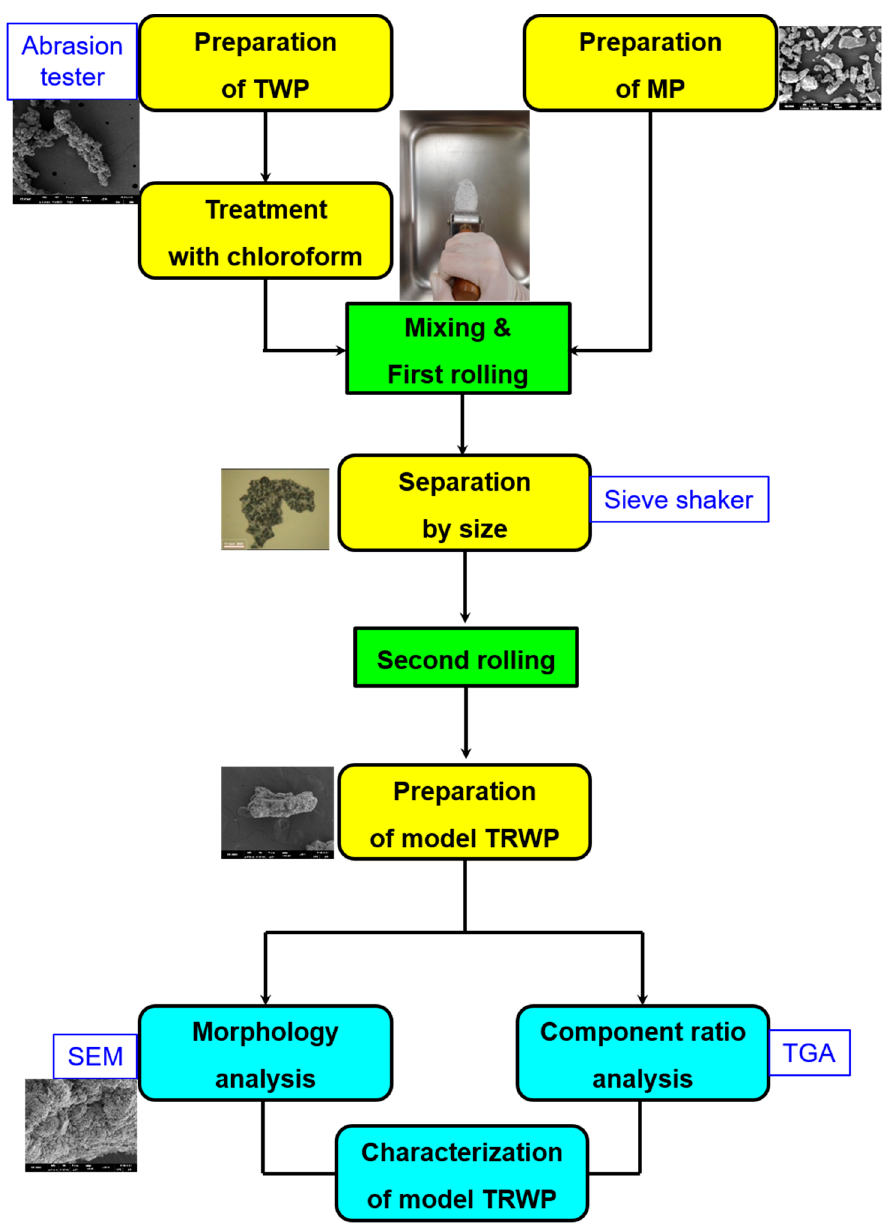
Figure 6. Preparation and characterization process of model TRWPs.